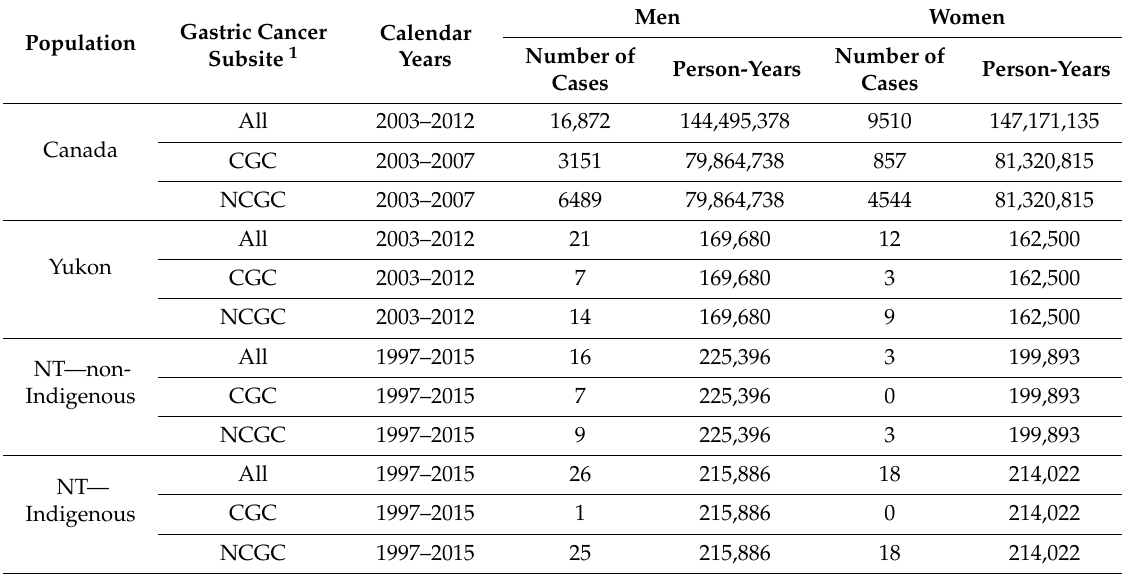
northern territories, Canada; various years.